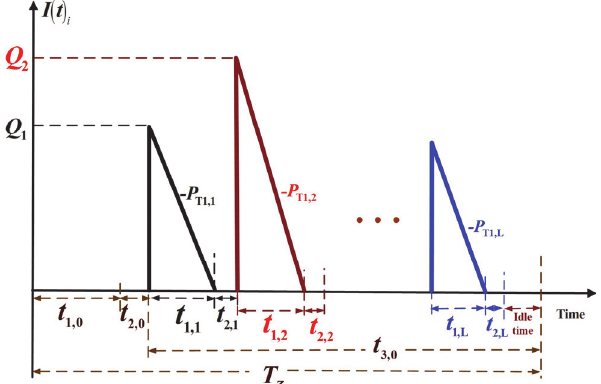
Fig. 2. The status of common parts in stage two of a replenishing cycle